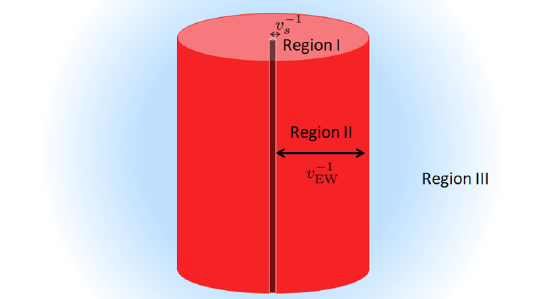
Figure 1 . Schematic picture of the energy density profile of the electroweak axion strings (type-A, B and C). The energy density consists of three parts. There is a one-dimensional thin object consisting of the radial component of the complex scalar φ ( r ) in Region I: r . v − 1 . We call this s . r . ( v − 1 (red region), the energy density is region the core of the string. In Region II: v − 1 EW ) s dominated by the Higgs fields and the electroweak gauge fields. This region is much fatter than Region I. In addition, there is the fattest part made from the gradient energy of the axion, leading to the logarithmically divergent tension. This is denoted by Region III: r & ( v EW ) − 1 (blue cloud). Note that the type-A string with tan β = 1 is a special case since it has only the global winding and its energy density does not have the Region